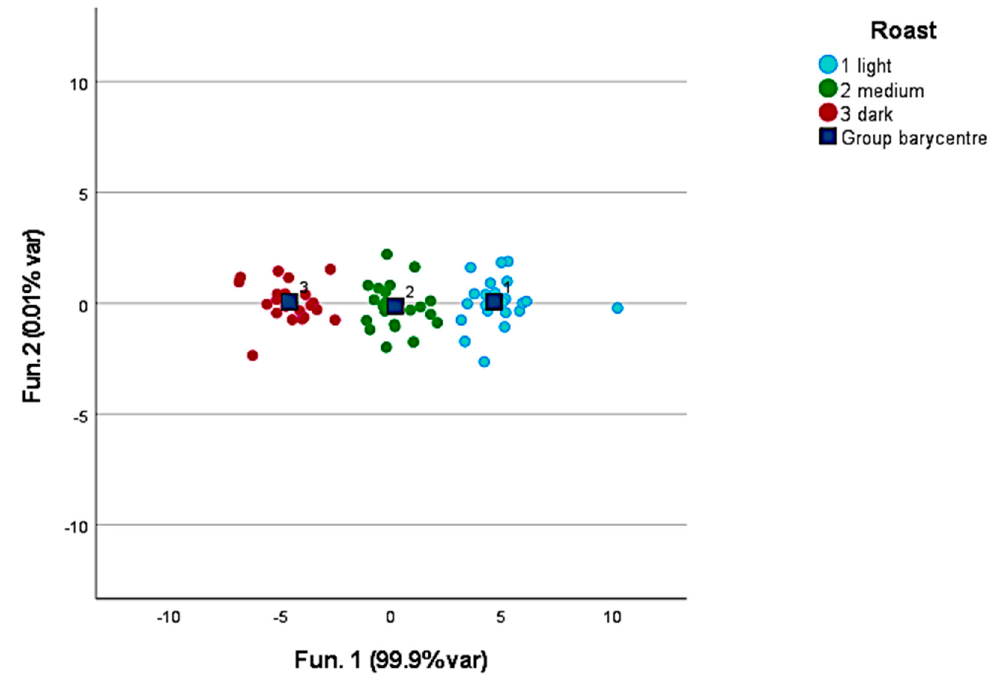
Figure 6. Discrimination of roasting levels in the washed coffee subcluster.